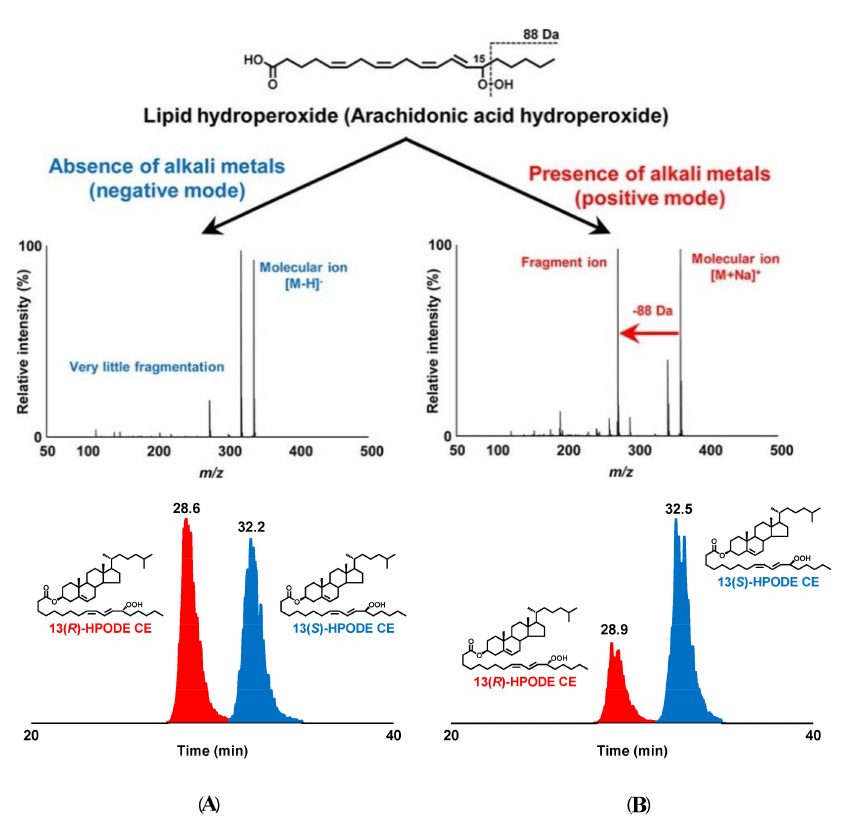
Figure 13. Diastereomeric analysis of synthesized 13(RS)-HPODE CE ( A ) and LOX-catalyzed oxida- tion product of CE ( B ). 13(RS)-HPODE CE was detected by structure-selective MRM ( m / z 703 > 247). Reprinted with permission from [79,80]. Copyright 2015, American Chemical Society.